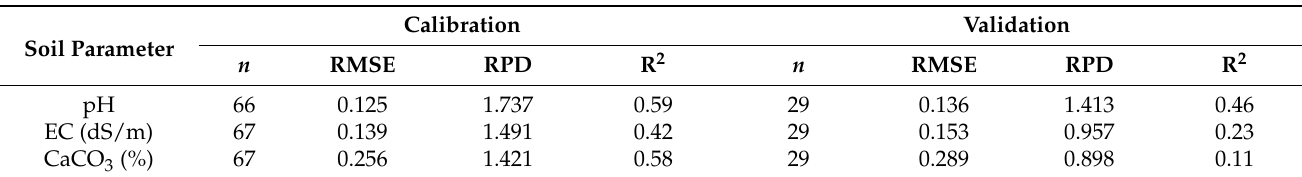
Table 6. The obtained data of MARS models for each soil